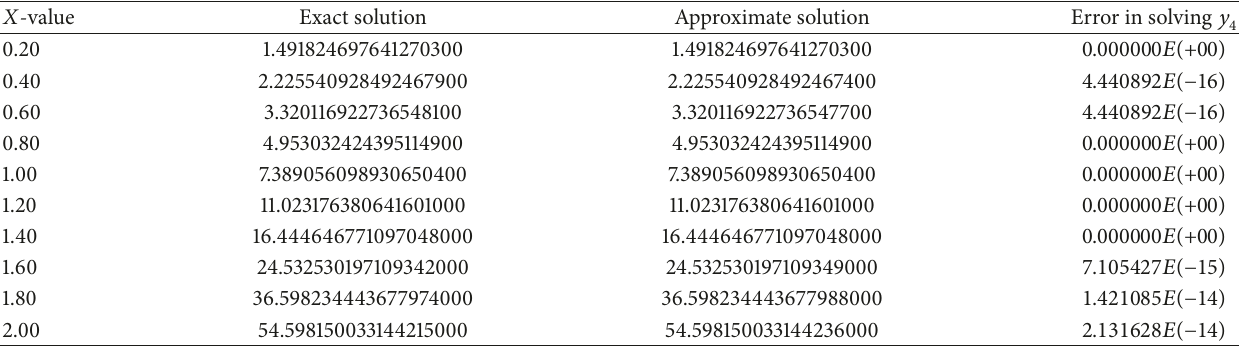
Table 8: Exact and approximate solutions for solving 𝑦 4 using the developed method.